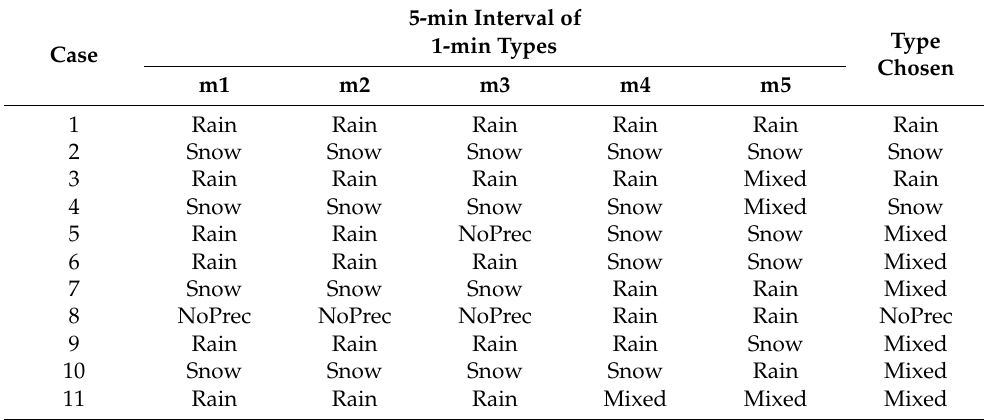
Figure A1. Flow diagram showing the hydrometeor reclassification from 1-min to 5-min periods. Table A1. Examples of precipitation type reclassification from 1-min to 5-min resolution.